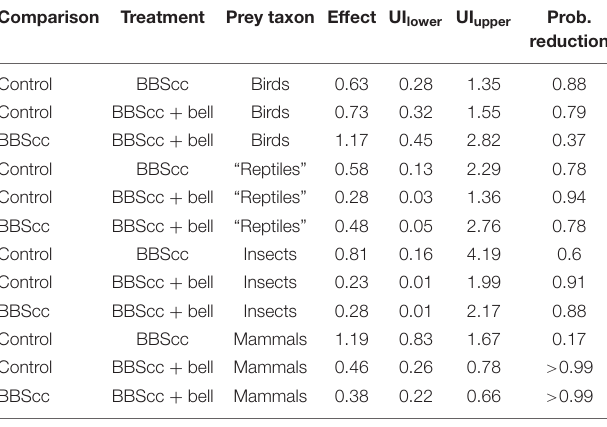
TABLE 2 | Multiplicative effects of the Birdsbesafe collar-cover (BBScc) and BBScc + bell treatments compared to the control (without BBScc and bell); or of BBScc + bell also compared to BBScc, with upper (UI upper ) and lower (UI lower ) limits of the 95% uncertainty interval (UI). Comparison Treatment Prey taxon Effect UI lower UI upper Prob.